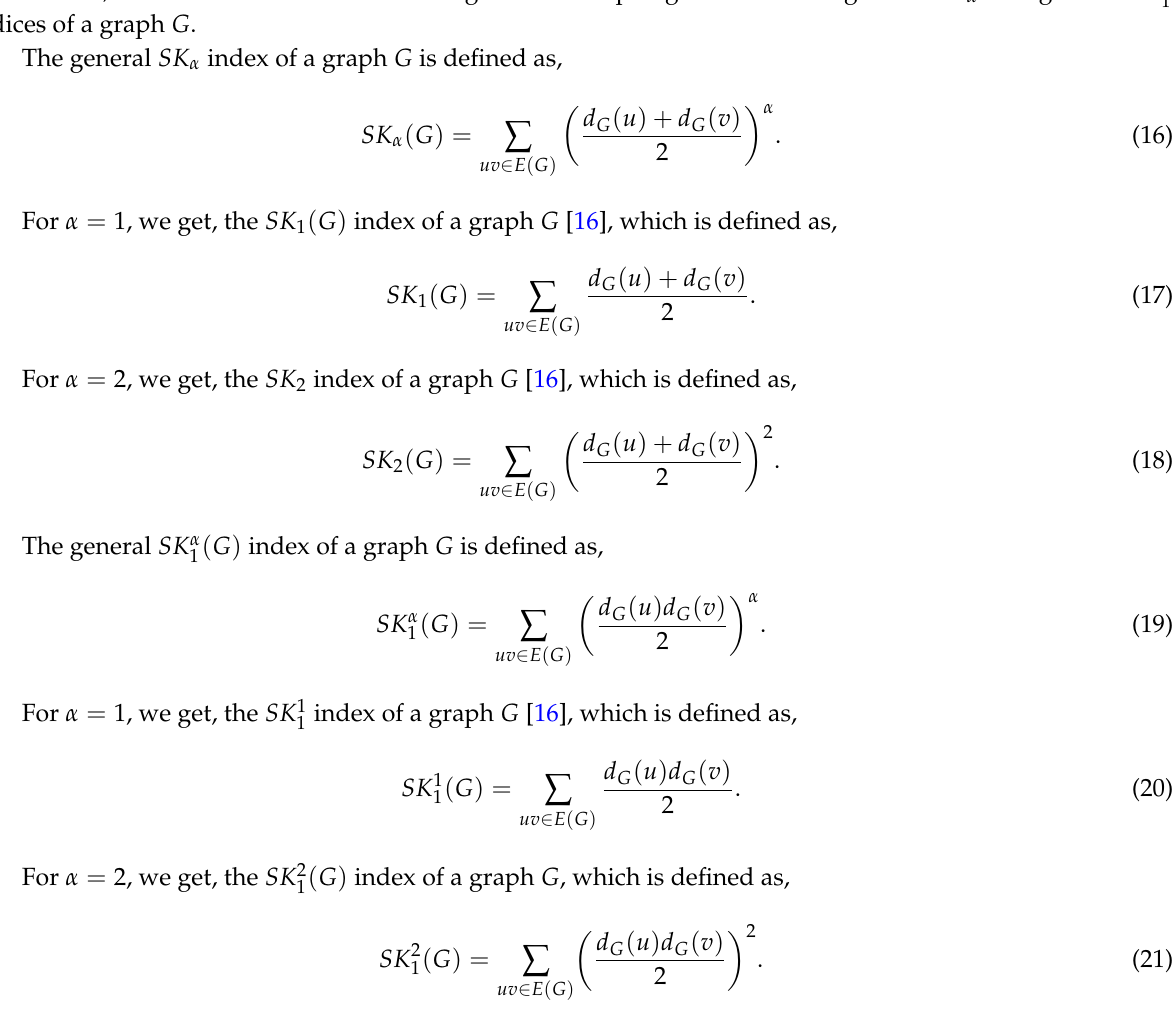
Table 1. Vertex partition of Basava wheel windmill W